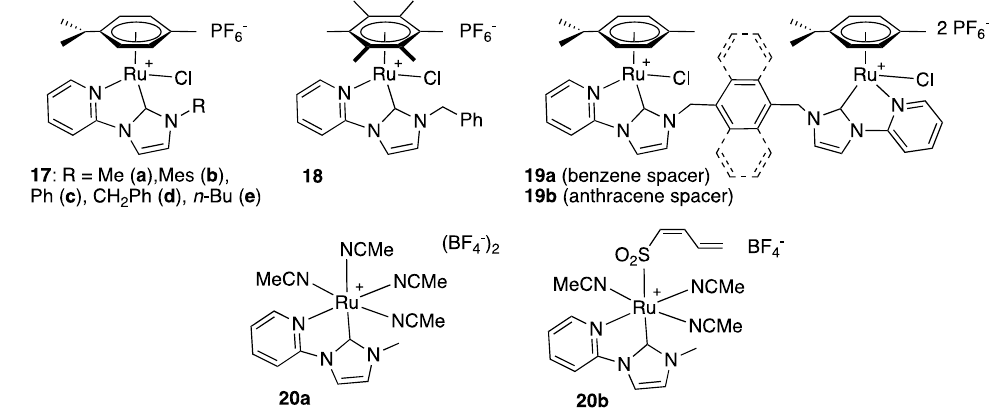
Figure 3. Pyridyl-functionalized imidazol-2-ylidene complexes 17 – 20 .